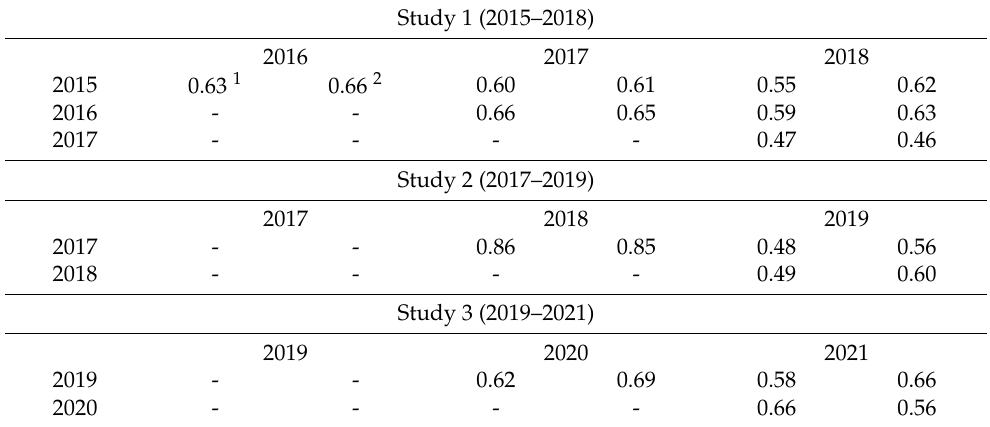
Table 1. Average Pearson’s and Spearman’s rank correlations between evaluation years within trials.